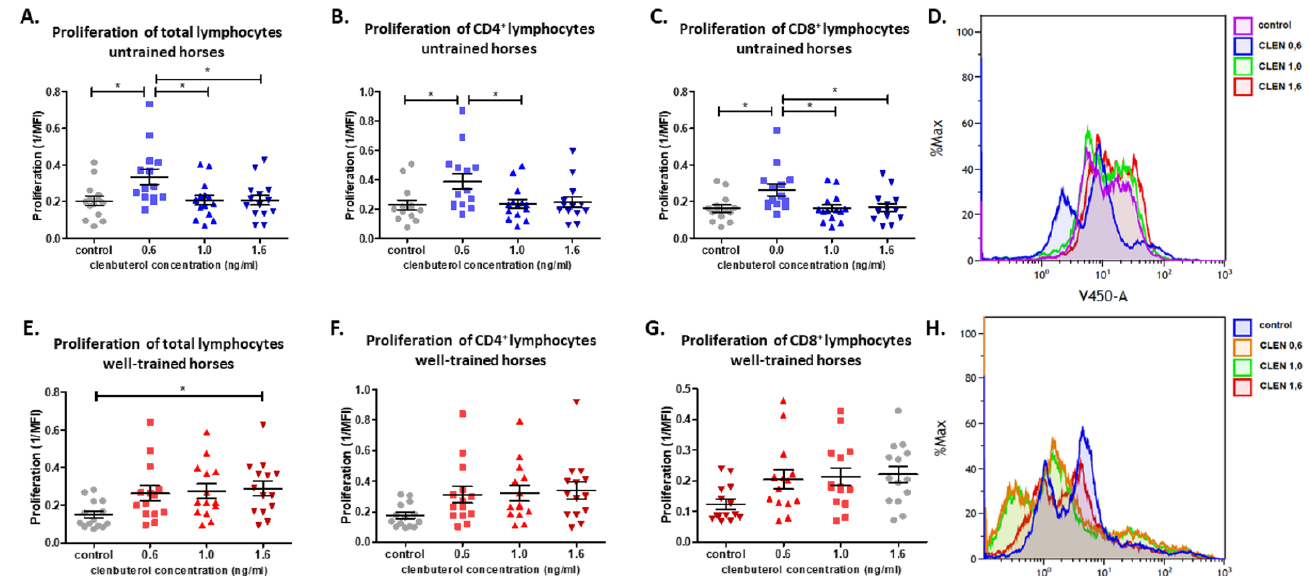
Figure 1. The graph shows total ( A , E ), CD4+ ( B , F ), and CD8+ ( C , G ) lymphocyte proliferation. Representative histogram showing proliferation of control and clenbuterol-treated lymphocytes harvested from untrained and well-trained horses. ( D , H ) Each dot represents one individual horse ( n = 28) and means ± SEM (standard error of the mean) are presented. Significance levels are: * p < 0.05.